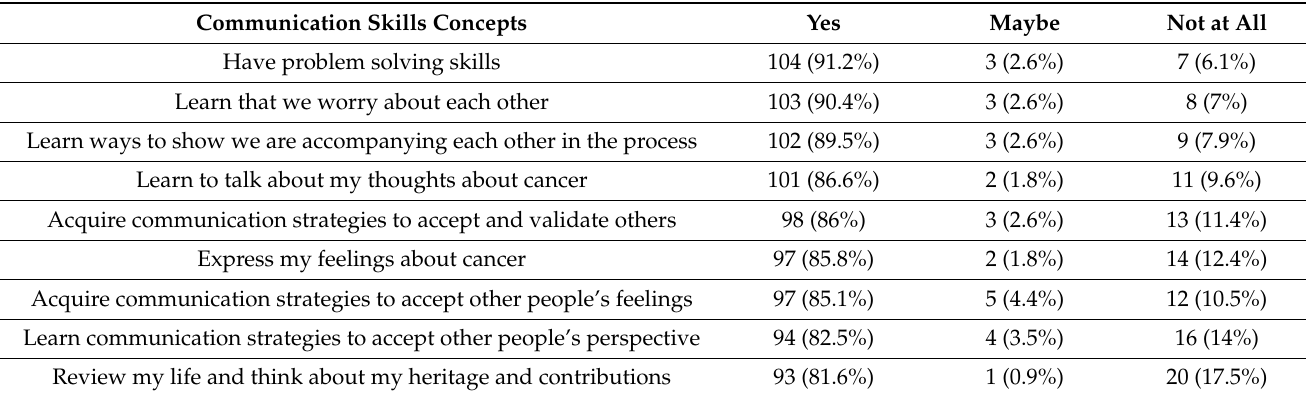
Table 8. Communication skills training concepts: Dyads.